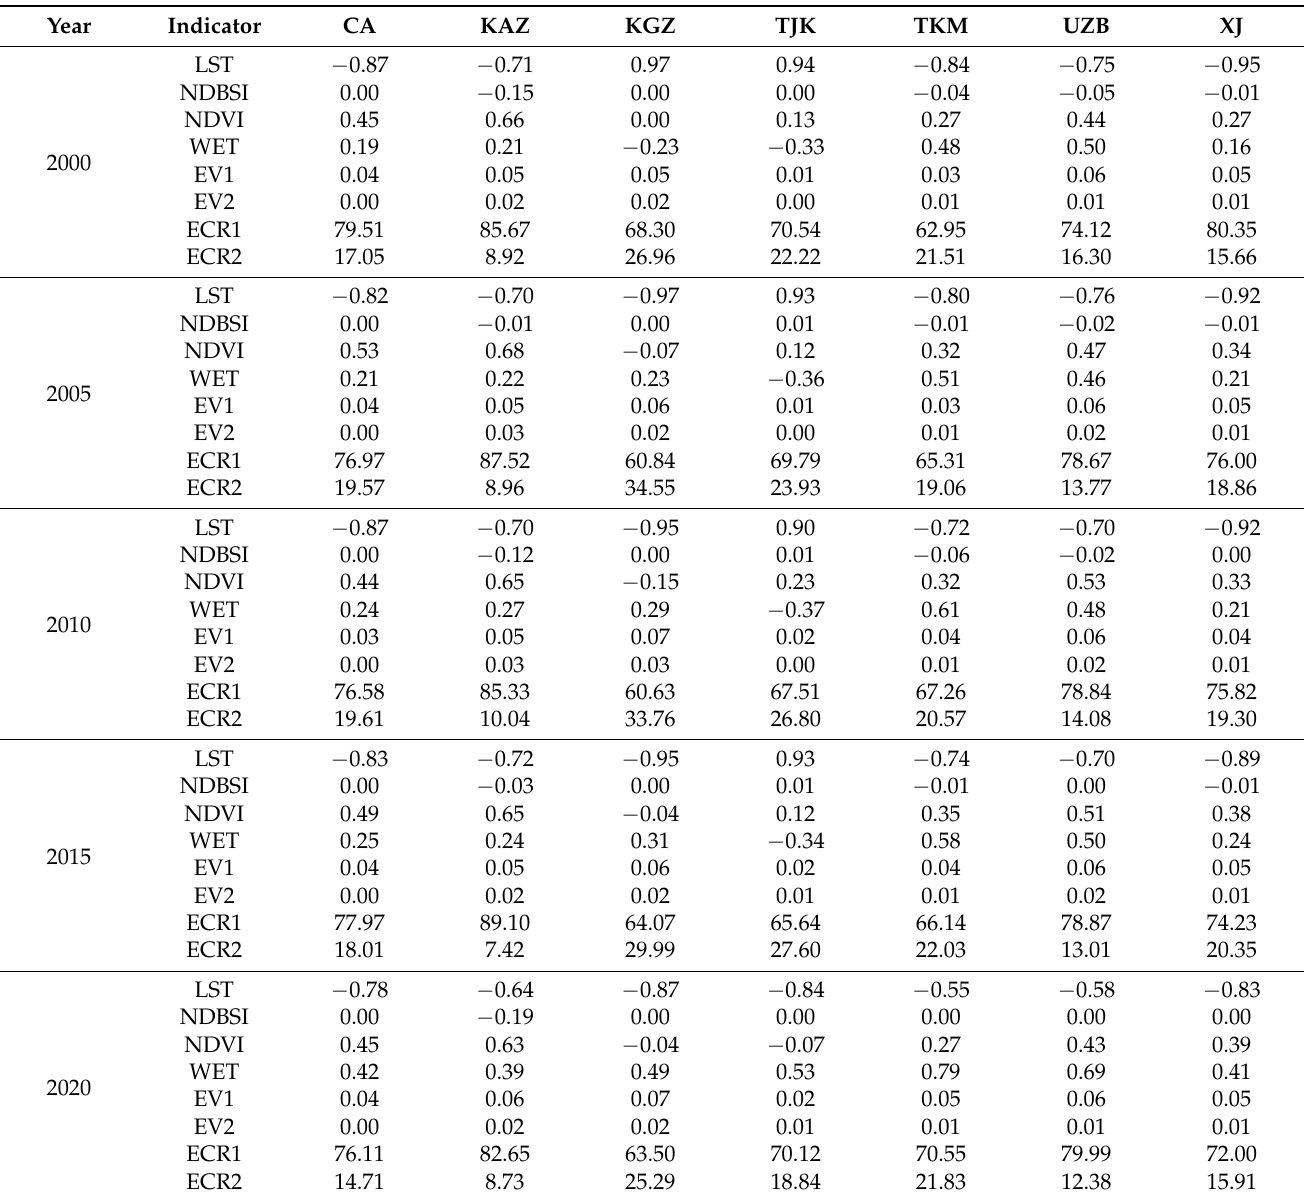
Table 1. Results of PCA for four